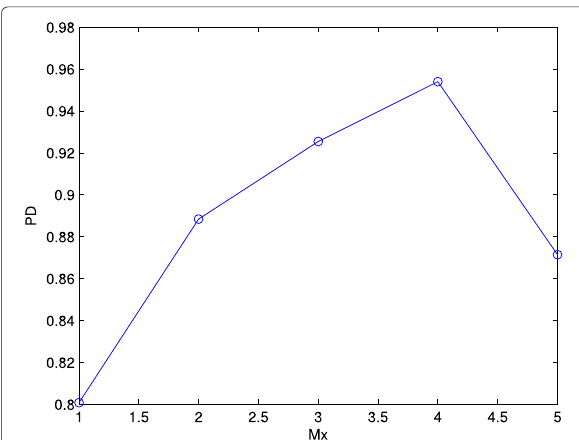
Fig. 2 Probability of false alarm for MA PF versus probability of false alarm for the local sensor p fa . Here, we have N (cid:2) = 27, b = 5, σ 2 = 1, σ w 2 = 4, k = 6, M x = 4, and f ov = 5. Simulations are based on 5000 runs